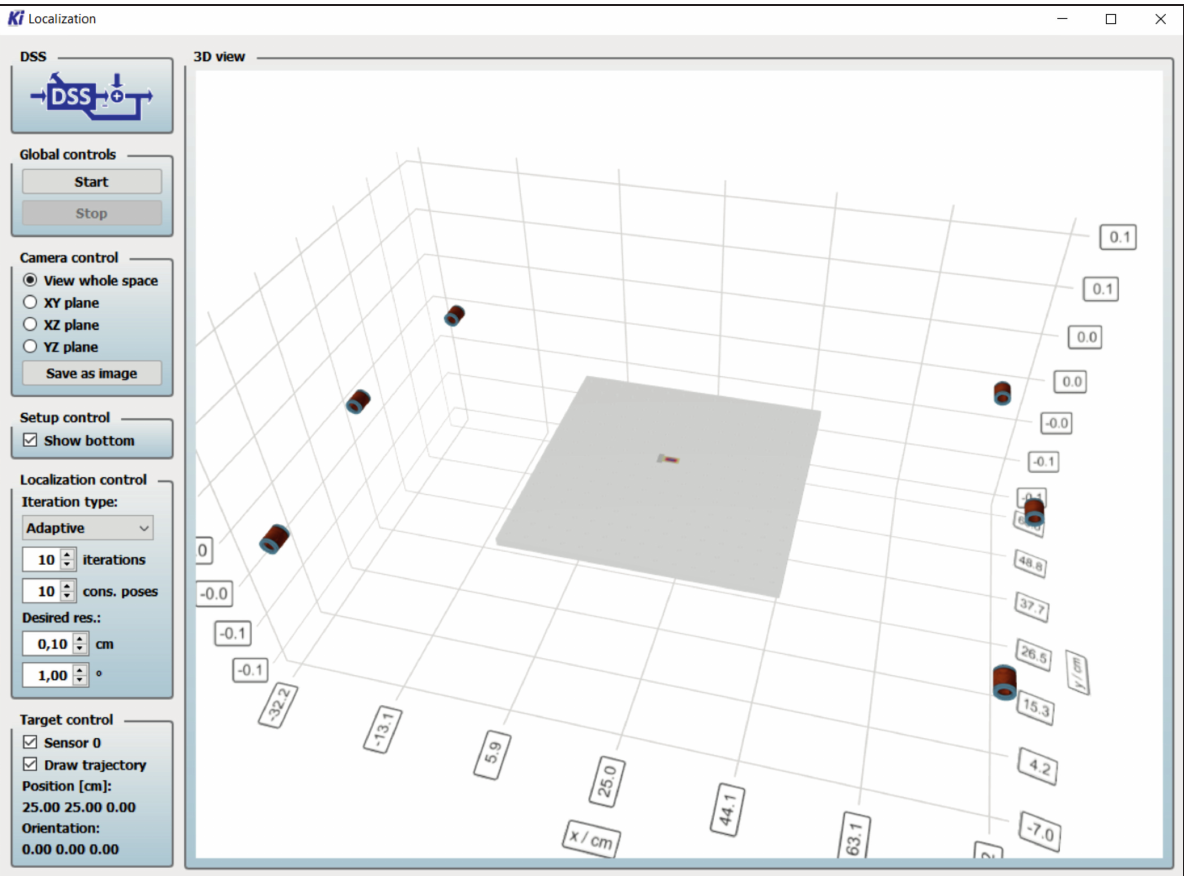
Figure 8. Graphical user interface of the real-time system used for localizing the magnetic sensors. The estimated position and orientation of the sensor is shown graphically in the 3D view and as text in the lower left corner. The number of iterations N it , the number of considered position-orientation pairs for refining the localization grid N b and the desired resolution in position and orientation are adjustable during